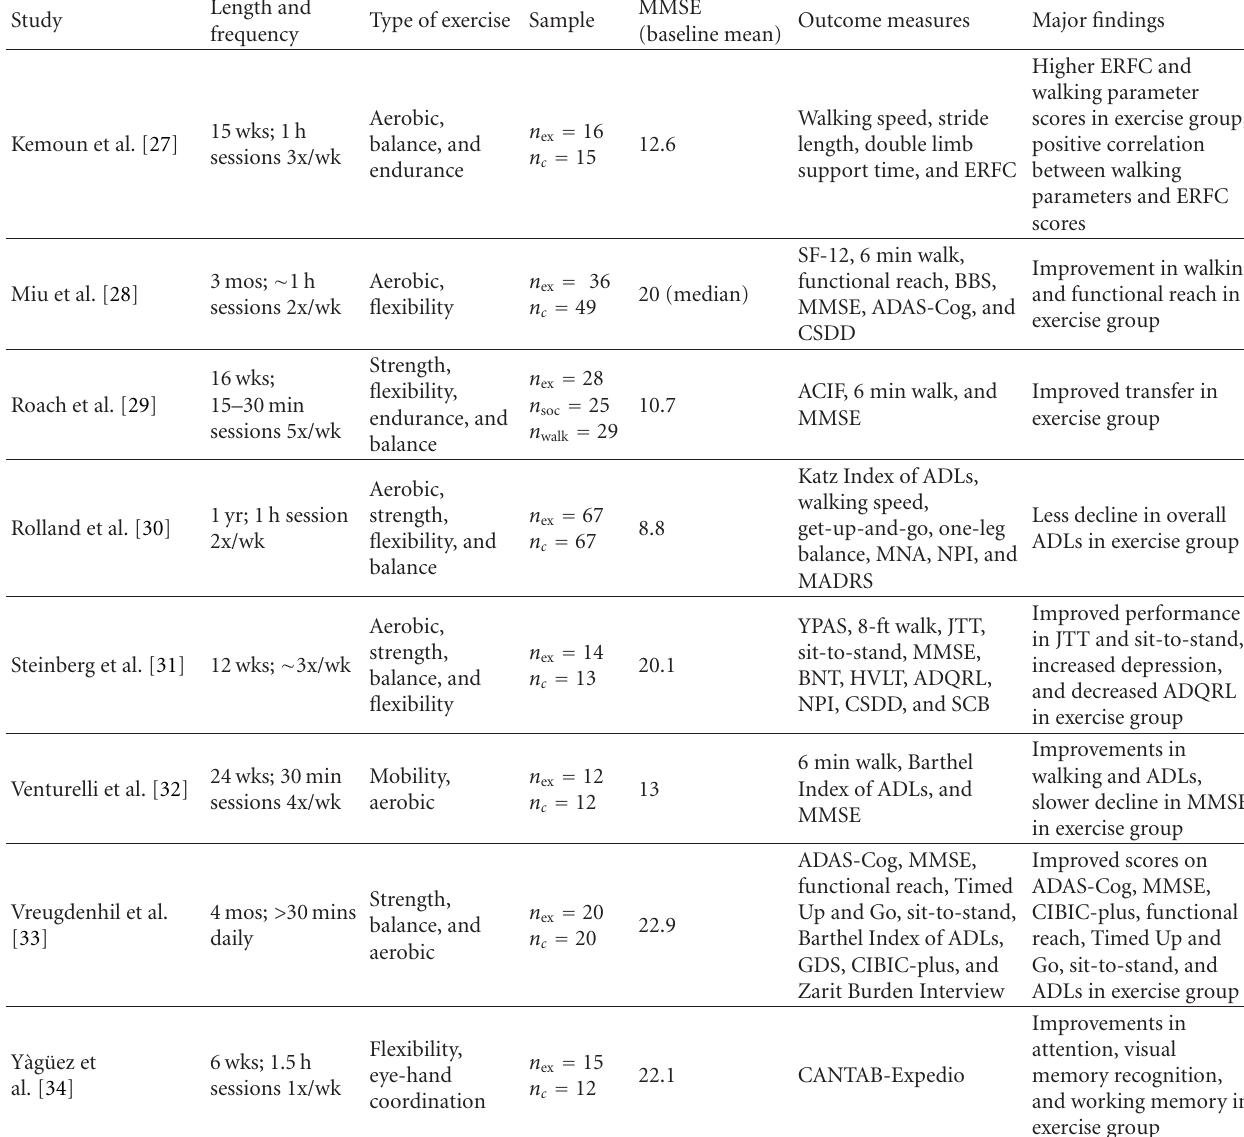
Table 1: Summary of randomized controlled trials of physical exercise regimes in AD